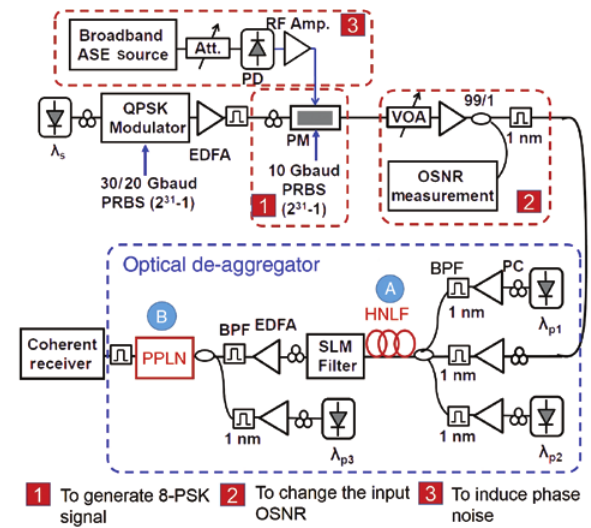
Figure 32: Deaggregation system design.